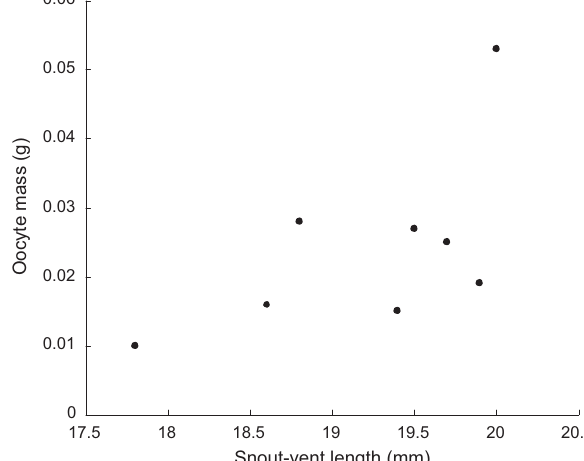
Figure 5. Relationship between snout-vent length (mm) and oo- cyte mass (g) of ovigerous females (in log) of I. parva in Santuário Ecológico da Serra da